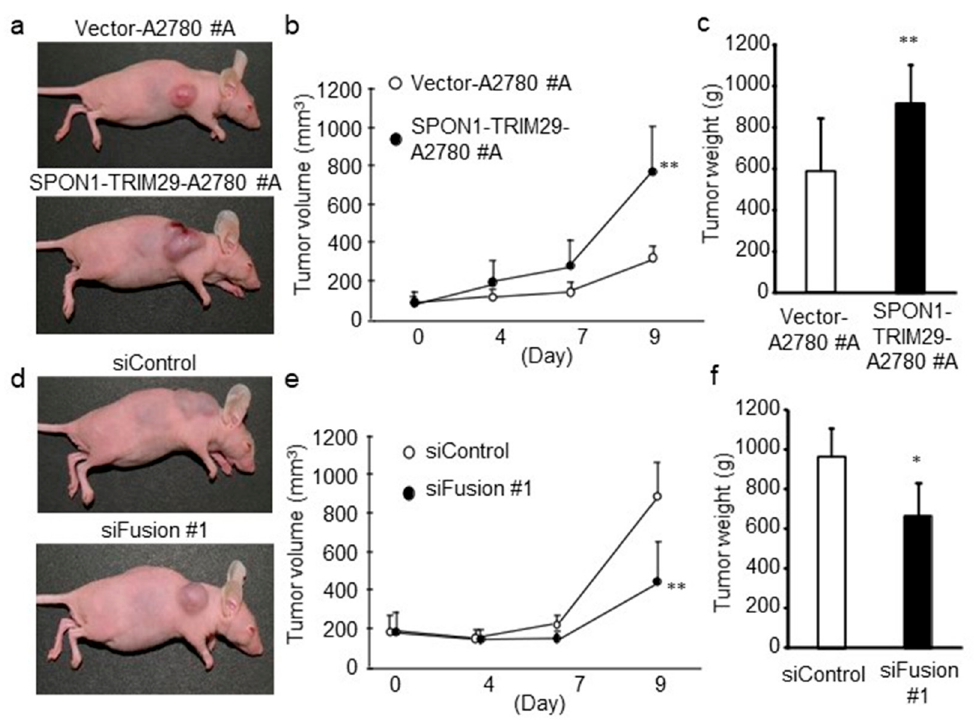
Figure 5. SPON1-TRIM29 expression promotes tumor growth of A2780 cells. ( a – c ) Increased tumor growth of SPON1-TRIM29-A2780 cells in athymic mice. Female athymic mice were inoculated with SPON1-TRIM29- or Vector-A2780 cells and the representative tumor-bearing mice at end point are indicated ( a ). Tumor volumes (mm 3 ) were estimated at the indicated time points ( b ) and dissected tumor weights at end point were indicated ( c ). ( d – f ) siRNA targeting SPON1-TRIM29 decreases tumor growth of SPON1-TRIM29-A2780 cells in athymic mice. Female athymic mice were inoculated with SPON1-TRIM29-A2780 cells and then administrated with control siRNA (siControl) or SPON1-TRIM29 siRNA (siFusion #1) every 3 days and the representative tumor-bearing mice at end point are indicated ( d ). Tumor volumes (mm 3 ) were estimated at the indicated time points ( e ) and dissected tumor weights at end point were indicated ( f ). Data are presented as means ± SD ( n = 7). * p < 0.05, ** p < 0.01, Student’s t -test.